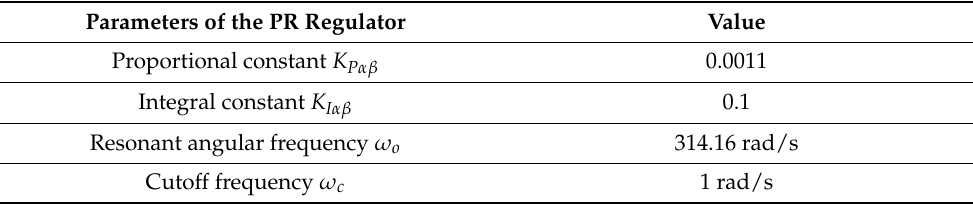
Table 2. Control subsystem parameters ( f CI = 610.4 Hz, PM I = 63.5 ◦